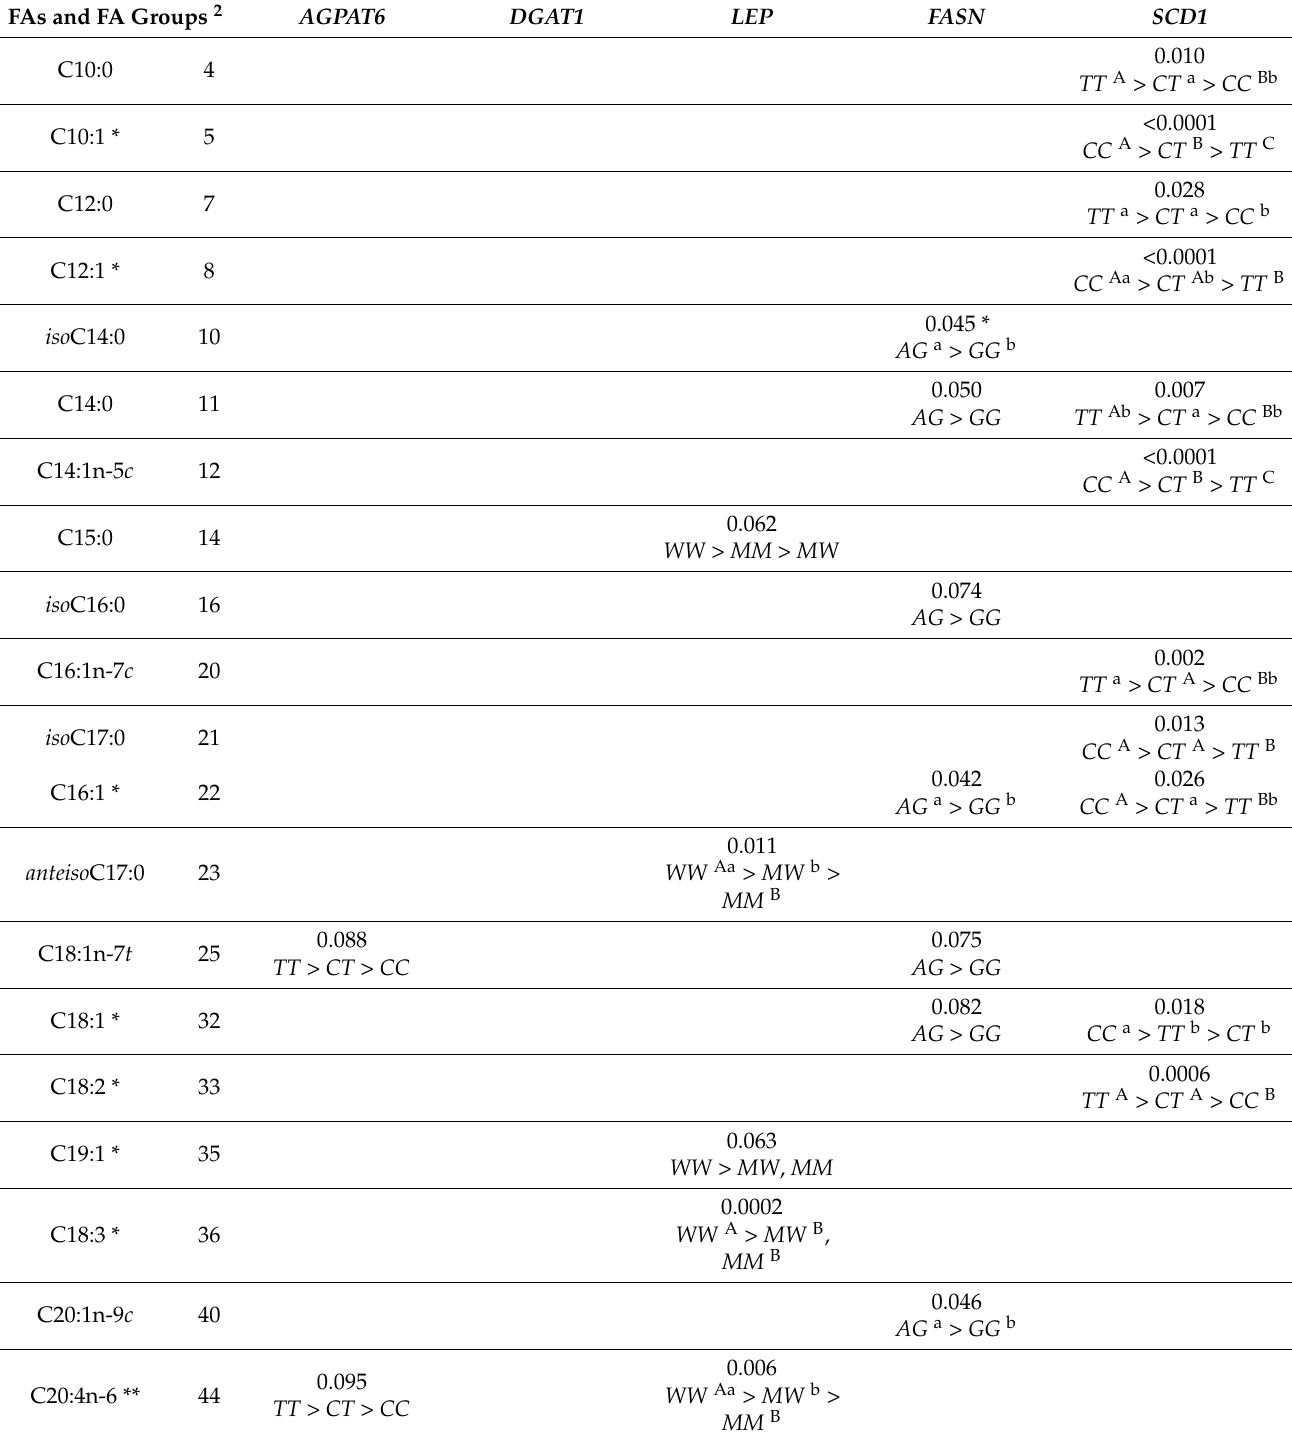
Table 2. Significance of differences among genotypes on the fatty acid (FA) proportions ( p -values) 1 . FAs and FA Groups